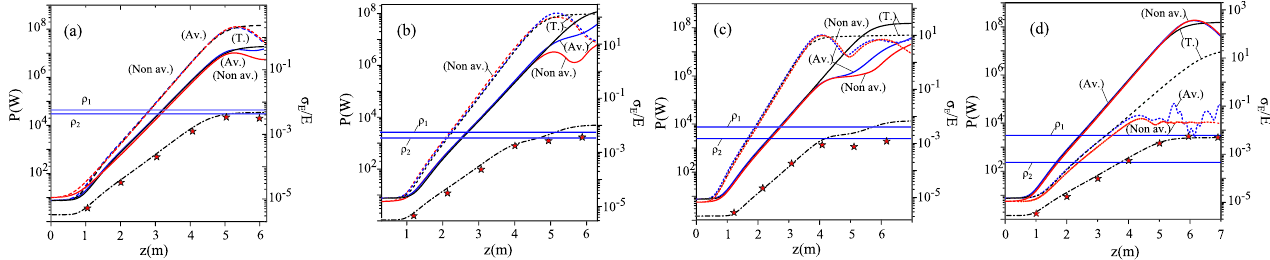
FIG. 2. Left axis: power P ð W Þ in the x (solid curves) and y (dashed curves) polarizations vs z ð m Þ . Comparison between nonaveraged (red curves) and averaged (blue curved) model for (a) m=n ¼ 1 . 5 , (b) m=n ¼ 2 , (c) m=n ¼ 5 , and (d) m=n ¼ 10 . In black, the logistic map P T 1 . On right axis, induced energy spread σ E from phase space (red stars) and theoretical (black curves). λ 01 ¼ 2 . 8 cm, ; 2 E